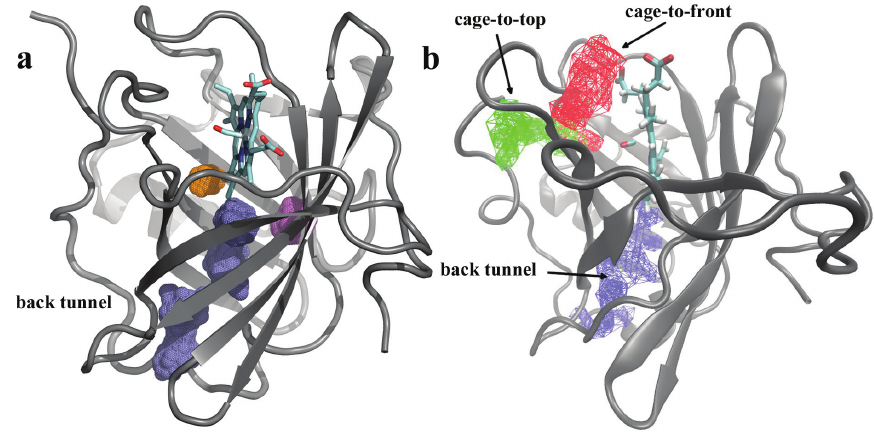
Figure 10. Topological analysis of inner cavities and pathways. ( a ) Representation of the cavities that form the inner tunnel in NP7 (blue) as well as two additional pockets found around the heme (orange and magenta) identified by the MDpocket analysis. ( b ) Pathways connecting the heme cavity and the bulk solvent in the closed form of